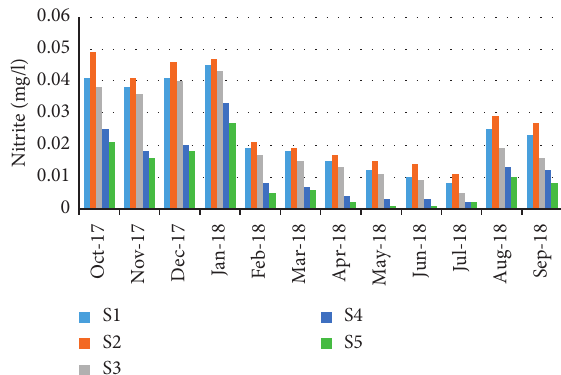
Figure 11: Spatial-temporal variation of ammonia in the Zegzel watercourse.